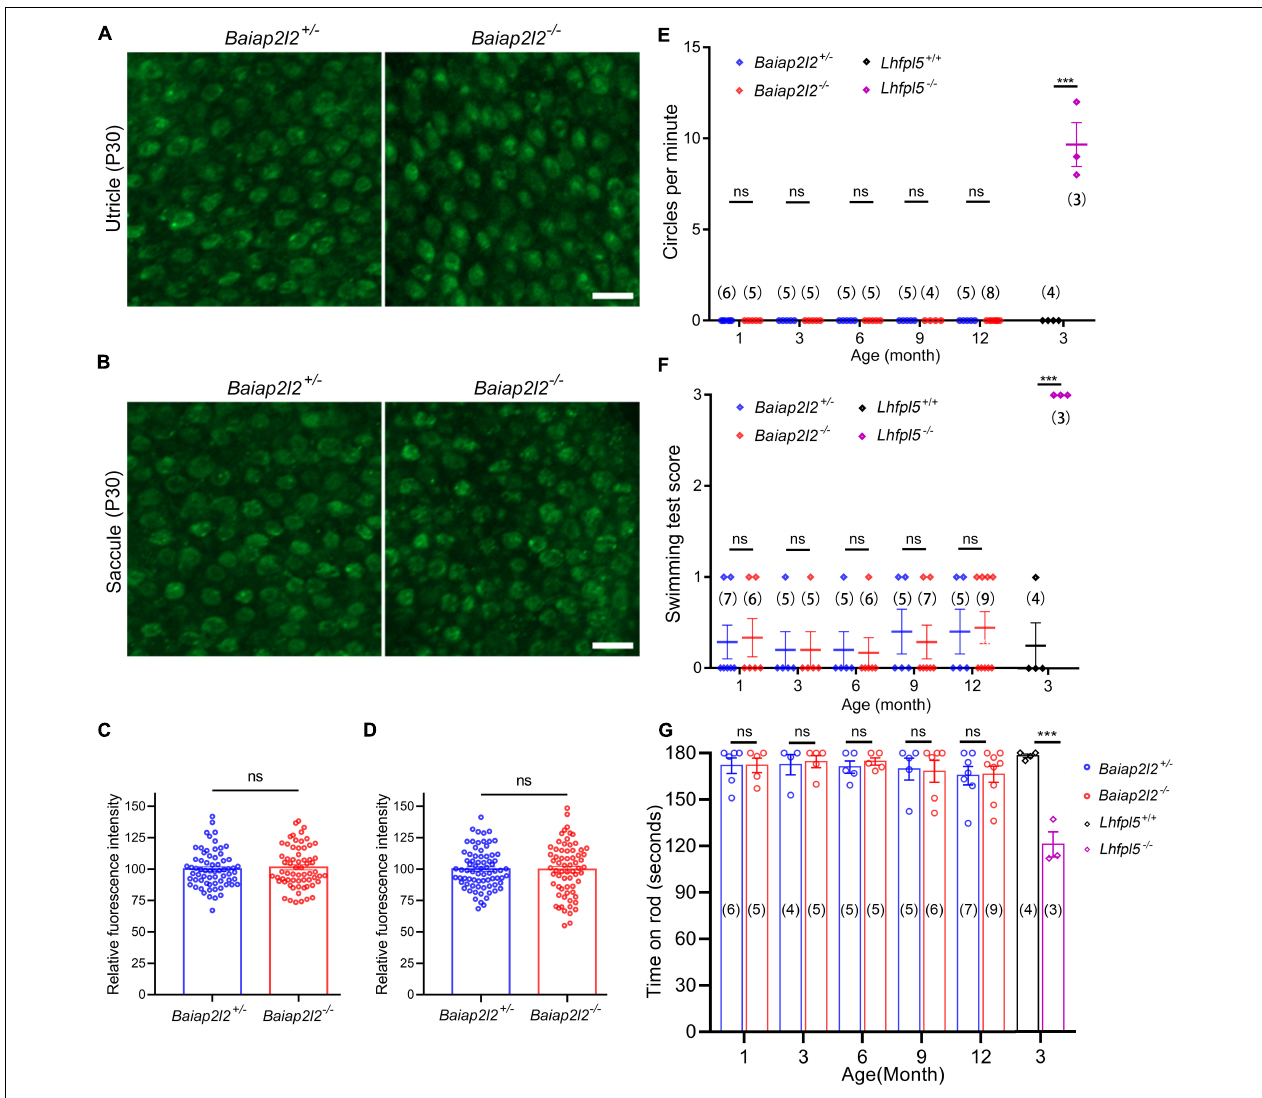
FIGURE 3 | Vestibular function is unaffected in Baiap2l2 knockout mice. (A,B) FM1-43FX uptake by P30 utricular (A) and saccular (B) hair cells from Baiap2l2 + / − or Baiap2l2 − / − mice was examined using confocal microscope. Scale bars, 10 µ m. (C,D) FM1-43FX uptake was quantified according to the results from (A,B) , respectively. (E–G) The vestibular function of Baiap2l2 + / − or Baiap2l2 − / − mice of different ages was evaluated by examining circling stereotyped movement (E)